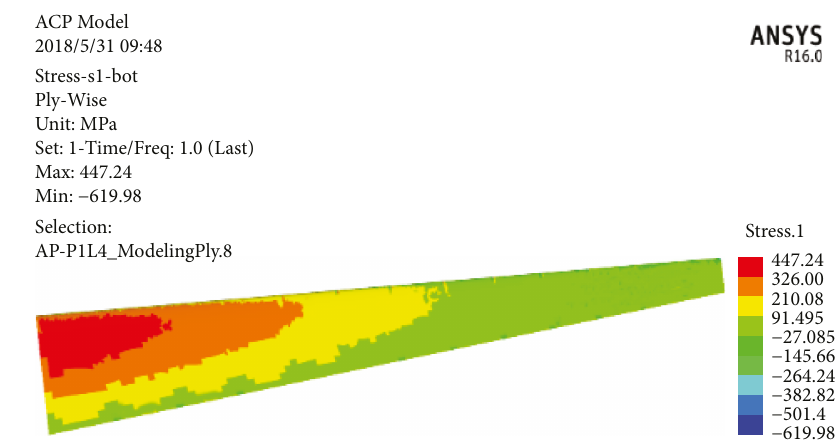
Figure 28: Stress cloud diagram of the lower wing with the layer angle being ± 45 alone.